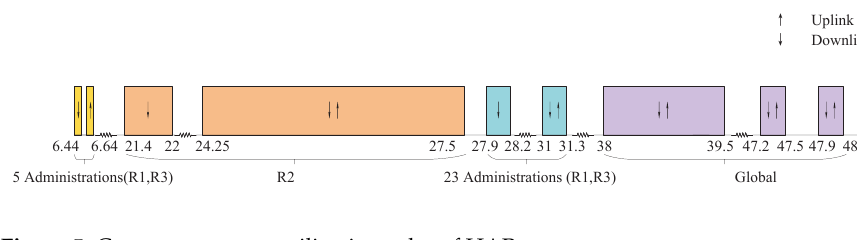
Figure 5. Current spectrum utilization rules of HAP. Table 4. Spectrum allocation of HAP